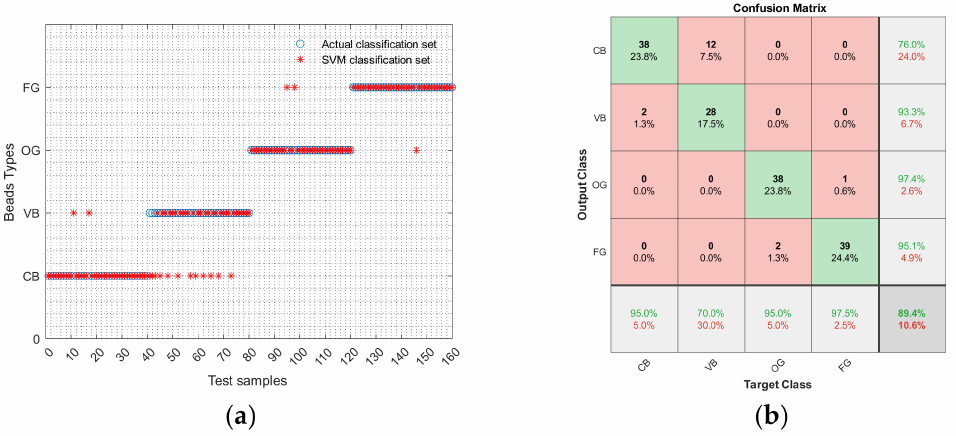
Figure 8. The classification results and confusion matrix of RBF-SVM. Micrographs shown in ( a , b ) are views of the classification results and confusion